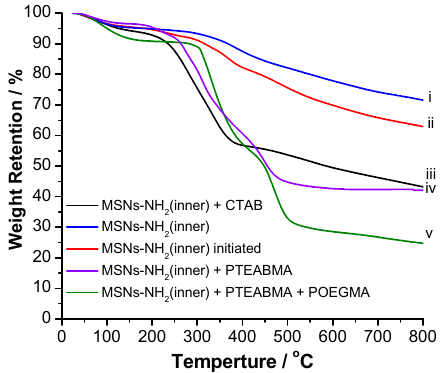
Figure 4. Thermogravimetric analysis (TGA) of the fabricated mesoporous silica nanoparticles. ( i ) MSNs-NH 2 (amine in inner surface), ( ii ) MSNs-Br (amine in inner surface), ( iii ) MSNs-NH 2 (amine in inner surface) and CTAB, ( iv ) PTBAEMA-MSNs (amine in inner surface), and ( v ) PTBAEMA-b-PEGMEMA-MSNs (amine in inner surface).